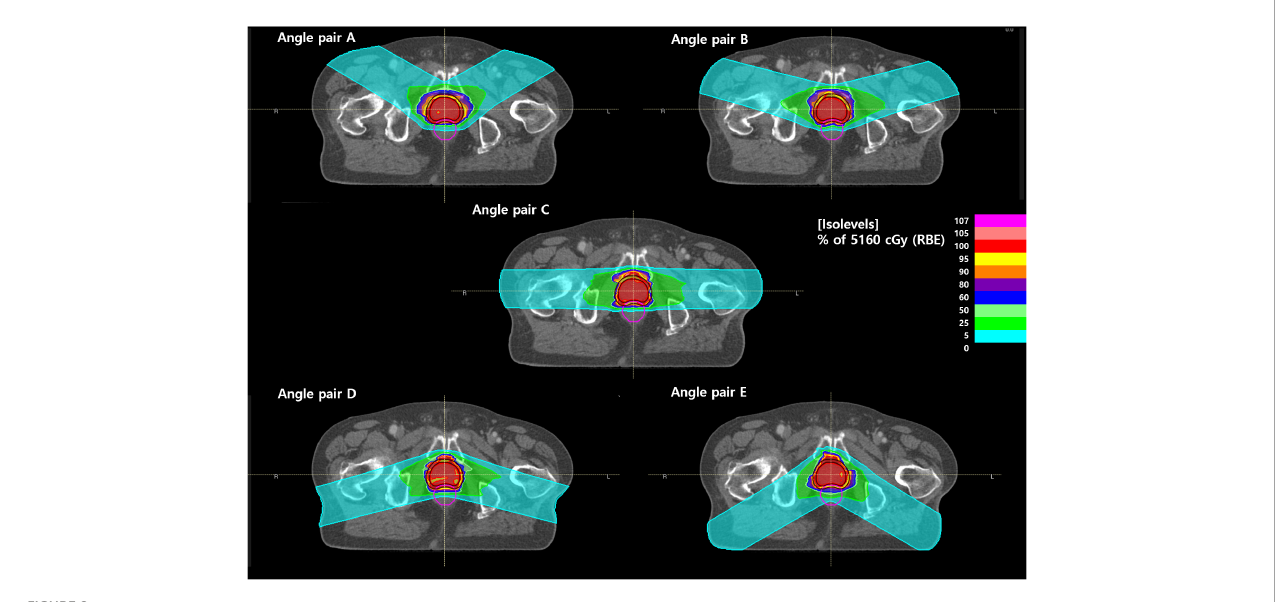
FIGURE 2 RBE-weighted dose distribution according to the angle pair (A – E)